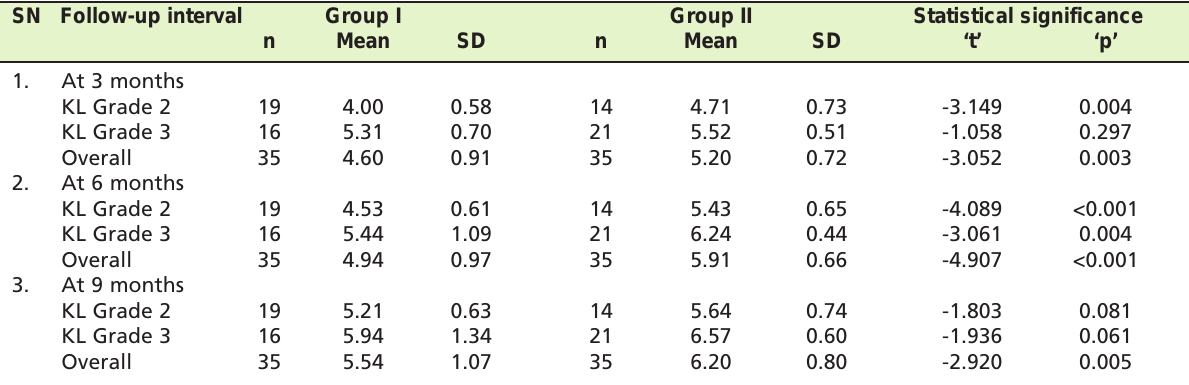
Comparison of post-intervention VAS scores at different follow-up intervals Table VI: